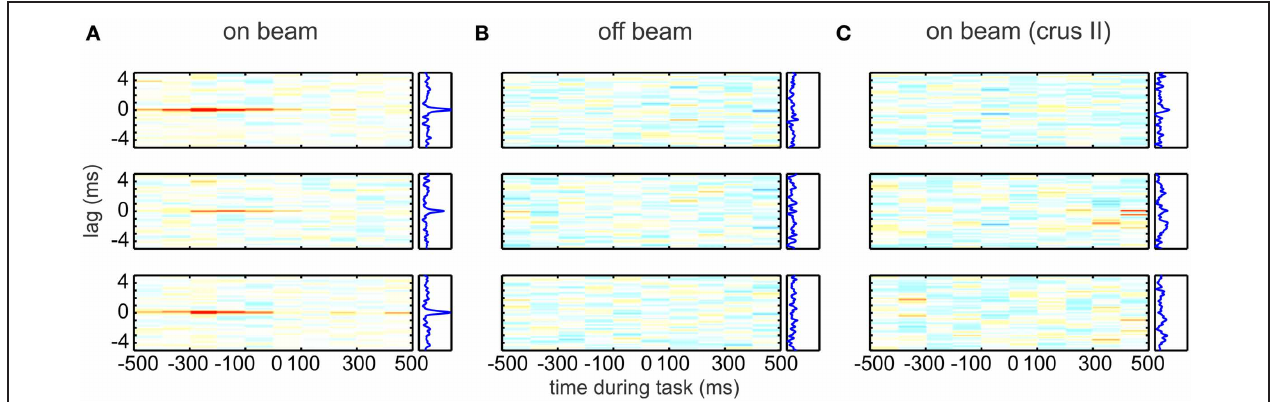
FIGURE 3 | Simple spike synchrony in Purkinje cells. On-beam Purkinje cells (Pcs) in the paramedian lobe fired precisely synchronized simple spikes (SSs) time-locked to behavior. Each plot represents the time-resolved cross-correlogram of Pc SS activity recorded at two different electrodes during reaching–grasping movements by awake rats. Average cross-correlations were calculated for epochs of 100-ms duration with a temporal resolution of spike delays of 40 µ s. In each plot, the abscissa indicates time during the movement. At time 0, the rat has completed paw extension and touches the food pellet. The ordinate indicates the cross-spike train interval. All plots use the same color map (from red = 0.01 through white = 0 to blue = − 0.01). Plots to the right side of the time-resolved cross-correlation matrix show the average excess correlation, i.e., the integral along the abscissa. The time-resolved cross-correlations shown here were generated from the data shown in Figure 1 of Heck et al. (2007). Data were analyzed by subdividing the experimental time into 100-ms bins and